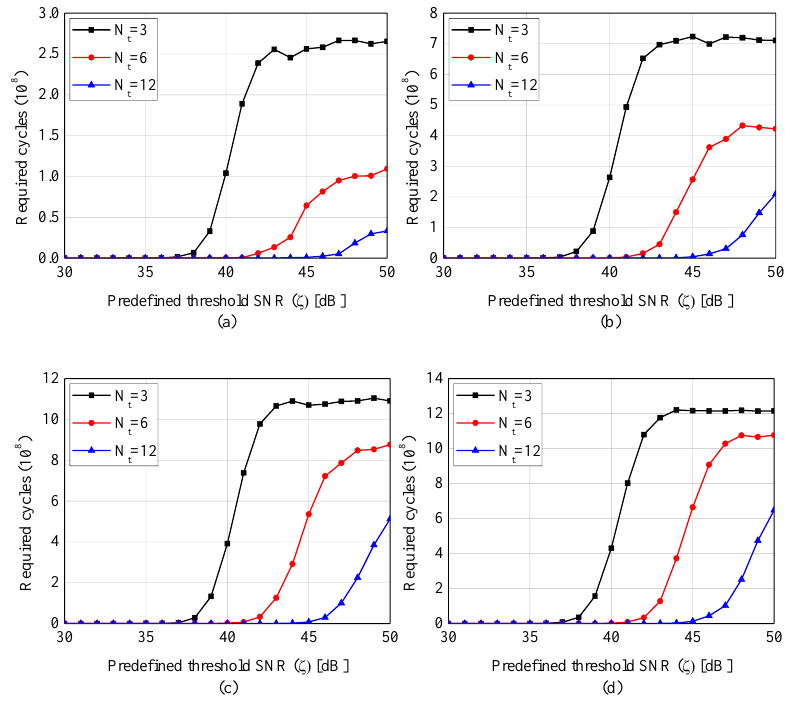
Figure 11. The measured operating cycles of the proposed algorithm versus ζ when M is set as 168 MHz, and ν is set as ( a ) 2 dB, ( b ) 4 dB, ( c ) 8 dB, and ( d ) 16 dB,